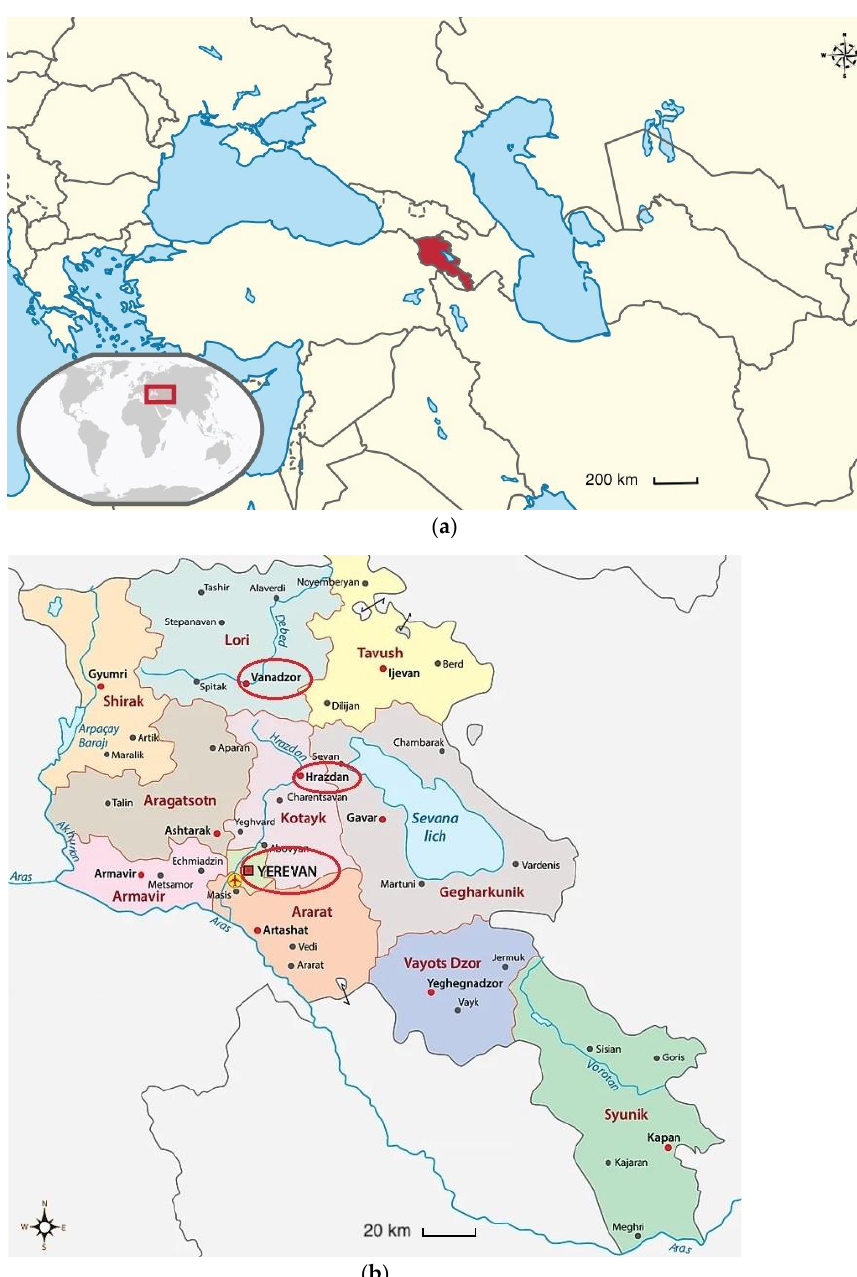
Figure 1. Maps of ( a ) the world (Armenia is in red) and ( b ) of Armenia (3 cities of this study — Yerevan, Vanadzor and Hrazdan — are marked with ovals).